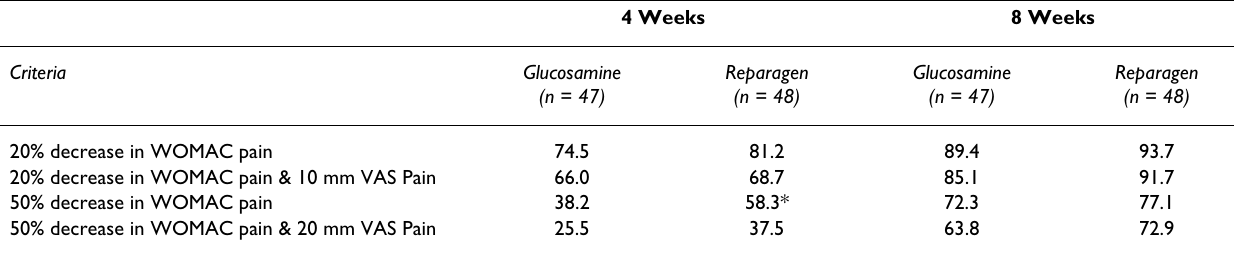
Table 4: Response rates of subjects to treatment based on pain assessments.